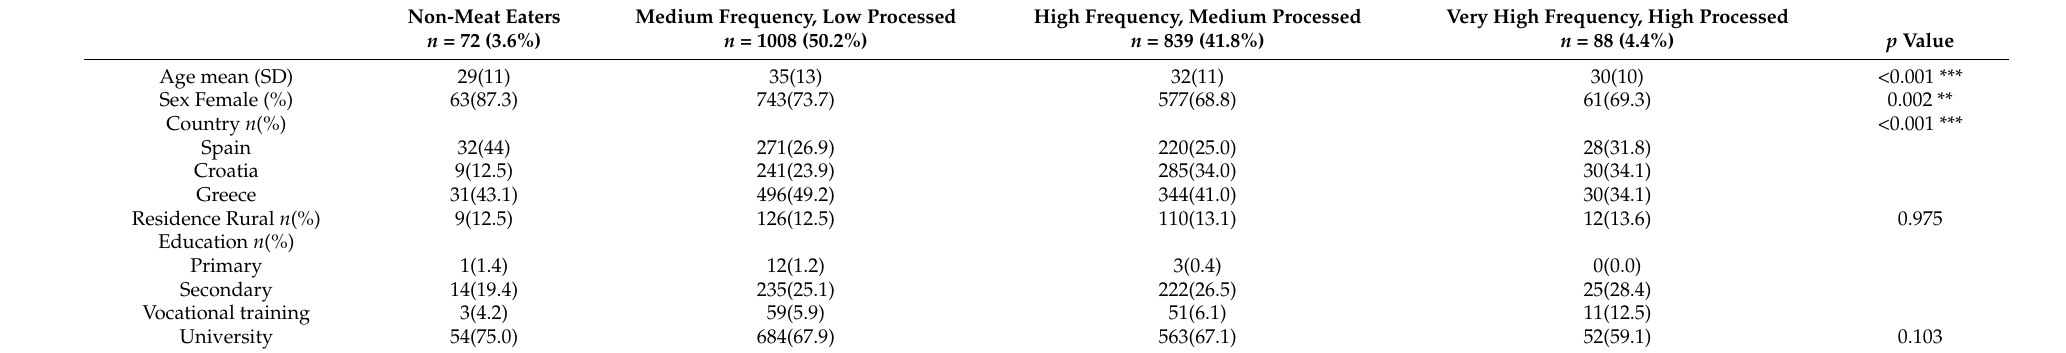
Table 1. Sociodemographic characteristics.